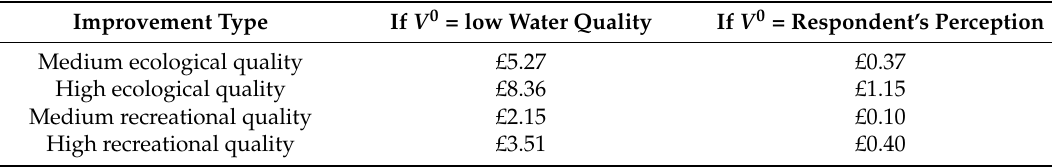
Table 6. WTP of Yare visitors (excluding rowers and swimmers) per km of improvement, per household, per year, accounting for perceived water quality.